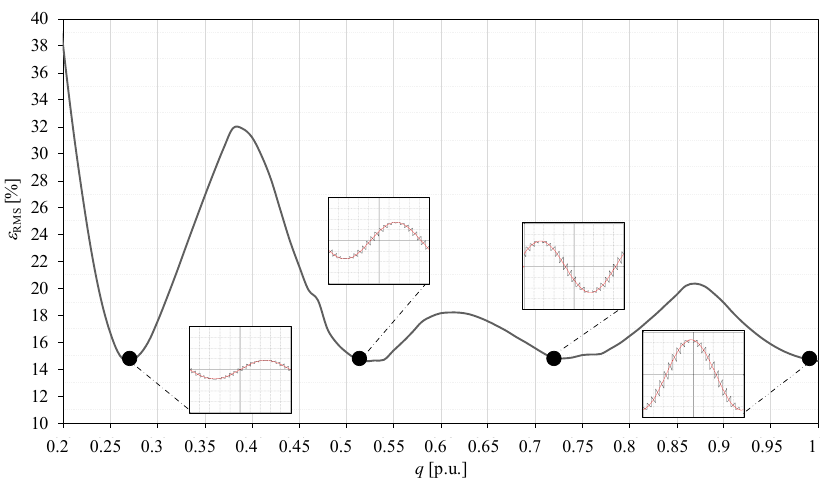
Figure 12. An error rate, defined by (21), for proposed NVM method: n AB1 = n AB2 = 209/209, n AB3 = 571/209, k f =